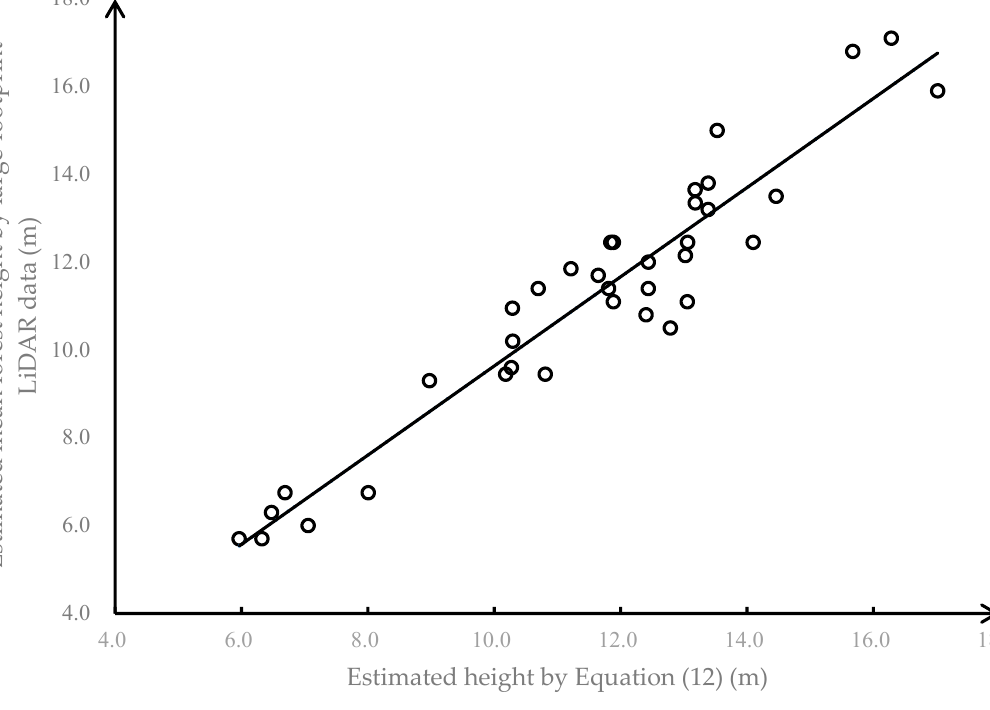
Figure 12. Mean forest height comparison between estimated by Equation (12) and estimated by large-footprint LiDAR data.